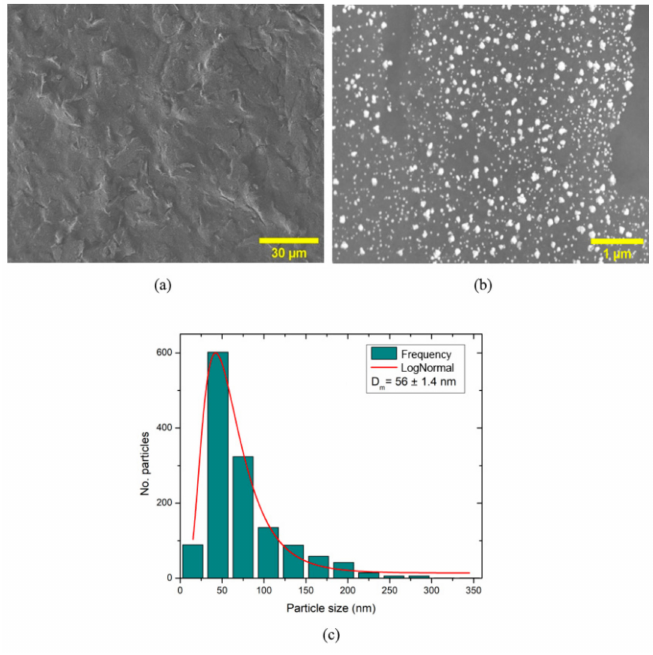
Figure 3. ( a ) Activated surface after electrodeposition, ( b ) a closer view of the resulting AuNps and ( c ) histogram of AuNps